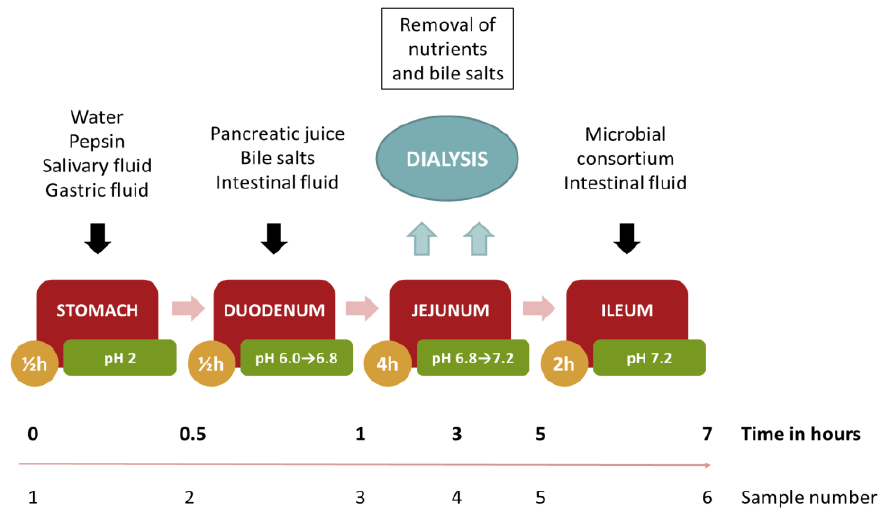
Figure5. FlowchartdetailingthesimulateddynamicdigestionbytheTheSmallestIntestine(TSI)model. Figure 5. Flow chart detailing the simulated dynamic digestion by the The Smallest Intestine (TSI) model.